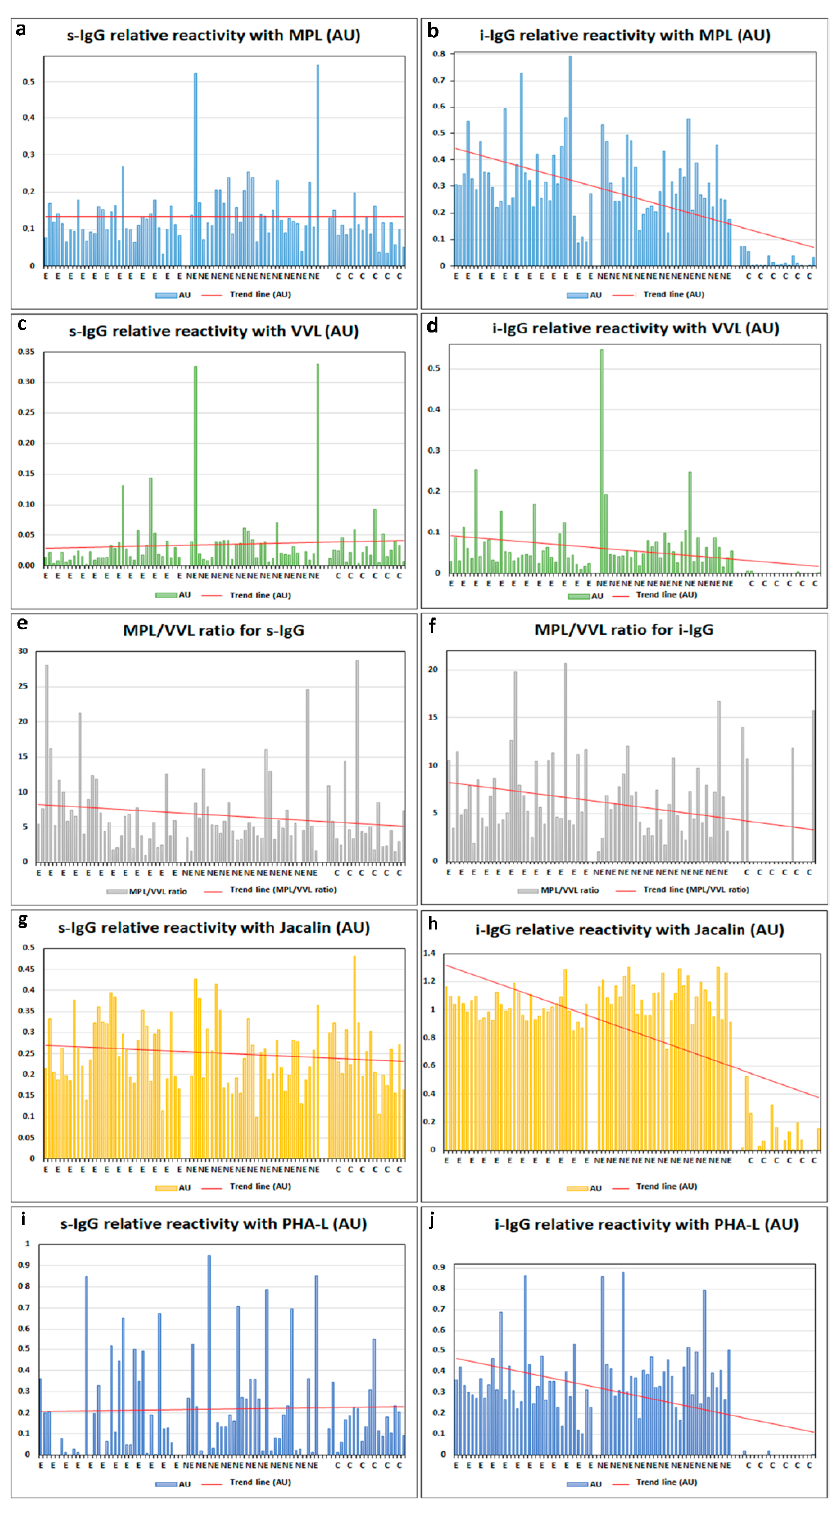
Figure 1. Relative reactivities of s-IgG and i-IgG glycans with specific lectins ( a – j ). MPL — Maclura pomifera lectin, VVL — Vicia villosa lectin, MPL/VVL — values of the ratio, Jacalin — Artocarpus integri- folia lectin, and PHA-L — Phaseolus vulgaris leucoagglutinin. For specificity of lectins see Materials and Methods section. E — advanced endometriosis, NE — non-endometriosis, and C — control group of healthy women. The trend line has been marked in red.